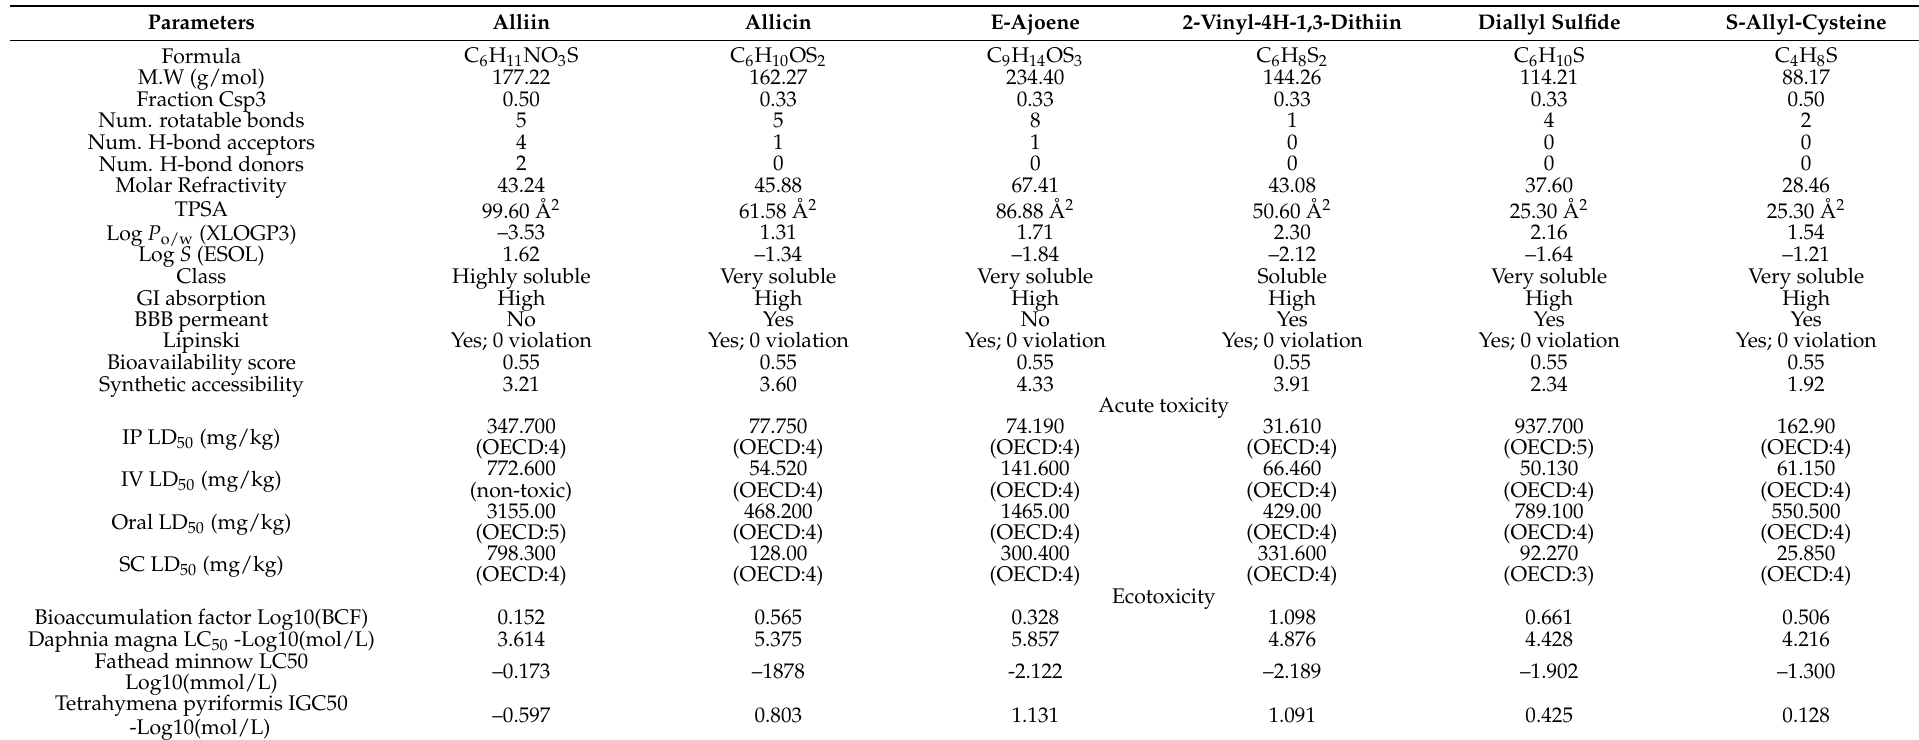
Table 1. Drug likeness, medicinal chemistry, and physicochemical and ADMET properties of the organosulfur small molecules from Allium sativum .